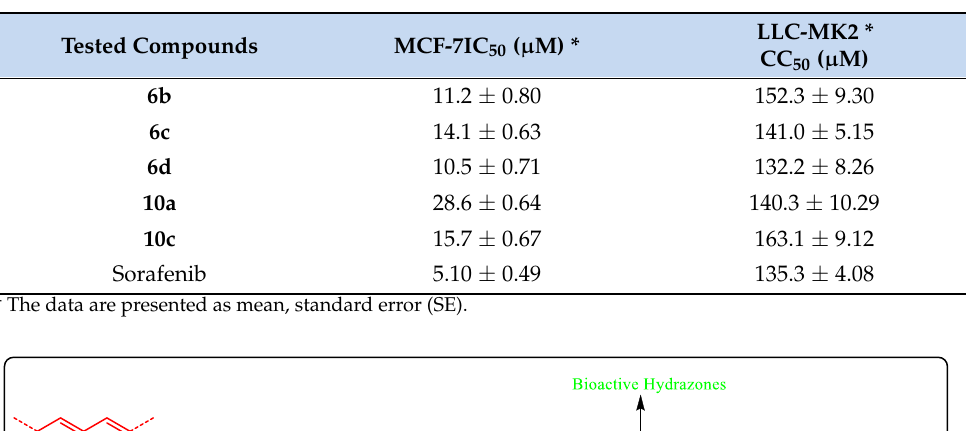
Table 3. In vitro cytotoxic activity of thiazoles 6b , 6c , 6d , 10a and 10c against MCF-7 and LLC-MK2.